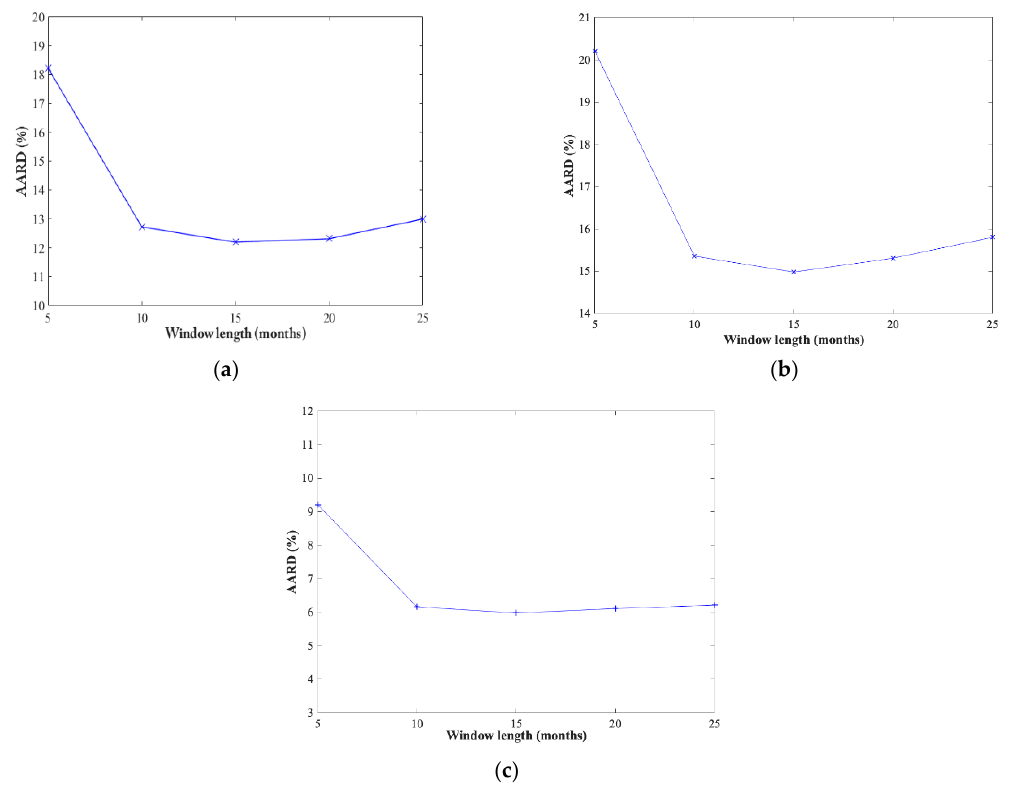
Figure 6. Effect of moving window length on prediction performance: ( a ) error curve of water saturation; ( b ) error curve of pressure; ( c ) error curve of oil rate.